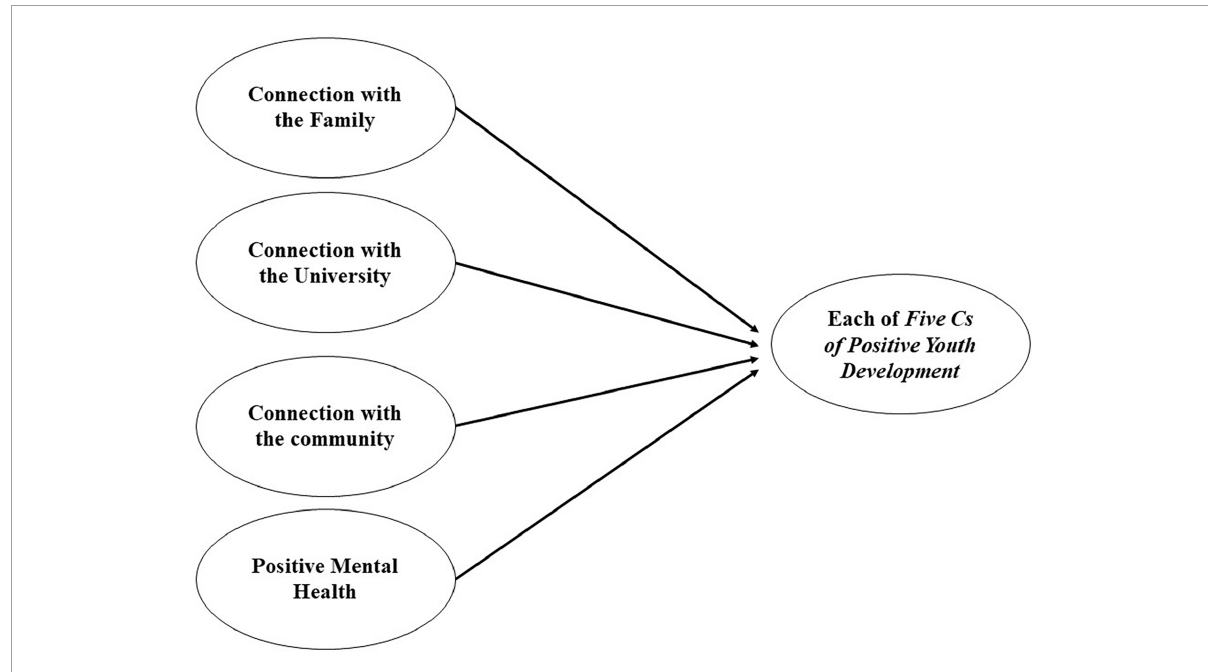
FIGURE1 Structural equation analysis